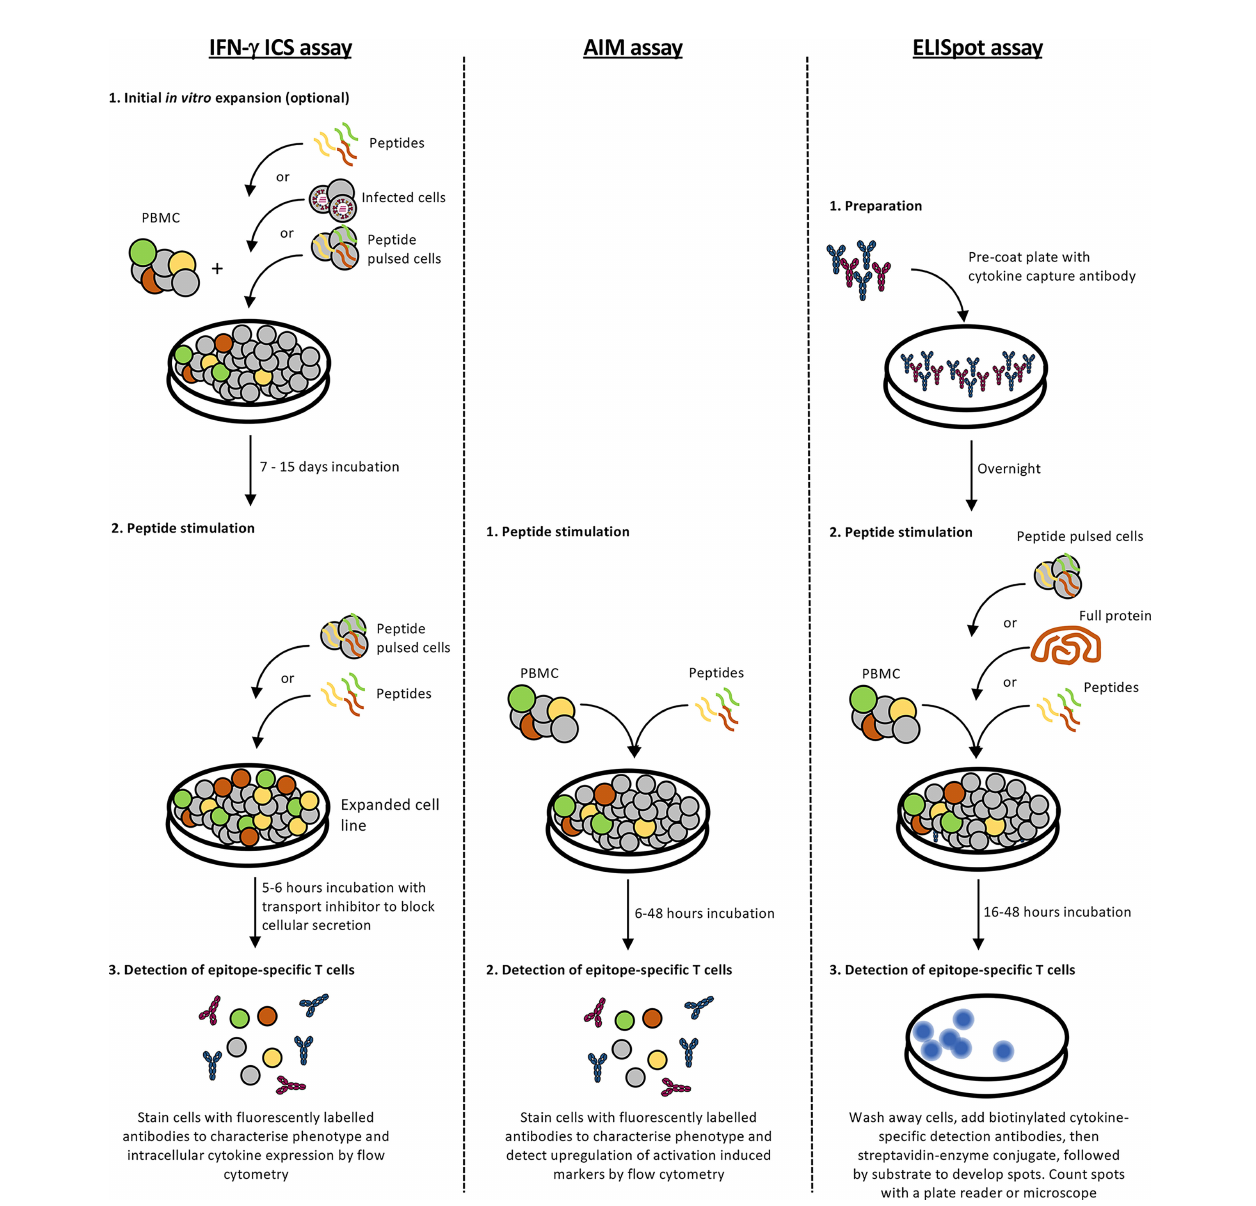
FIGURE 3 | Screening for immunogenic epitopes. A summary of enzyme-linked immunospot (ELISpot), intracellular cytokine staining (ICS) and activation-induced marker (AIM) assay protocols for validating immunogenic